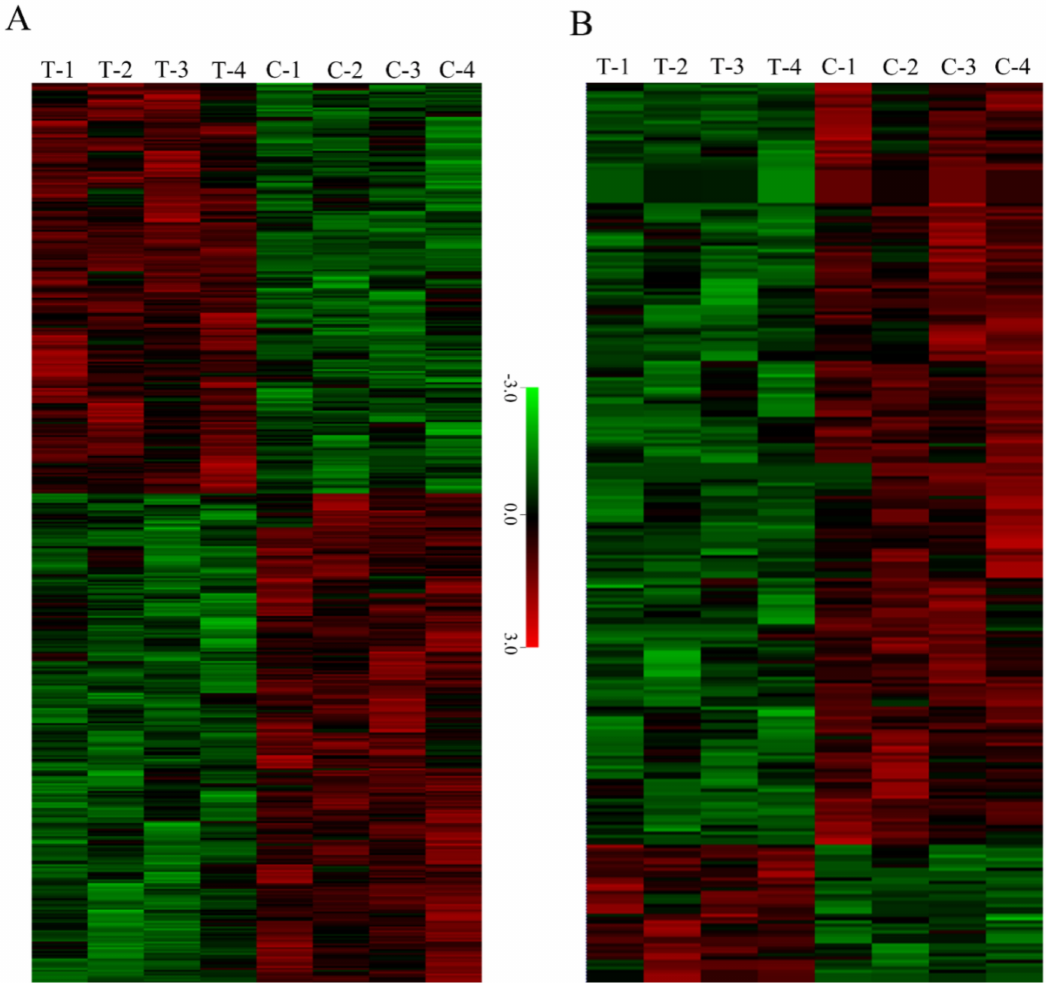
Figure 4. Hierarchical clustering of all of the differentially expressed protein ( A ) and phosphoprotein ( B ) profiles of tobacco leaves in control and TMV-infected